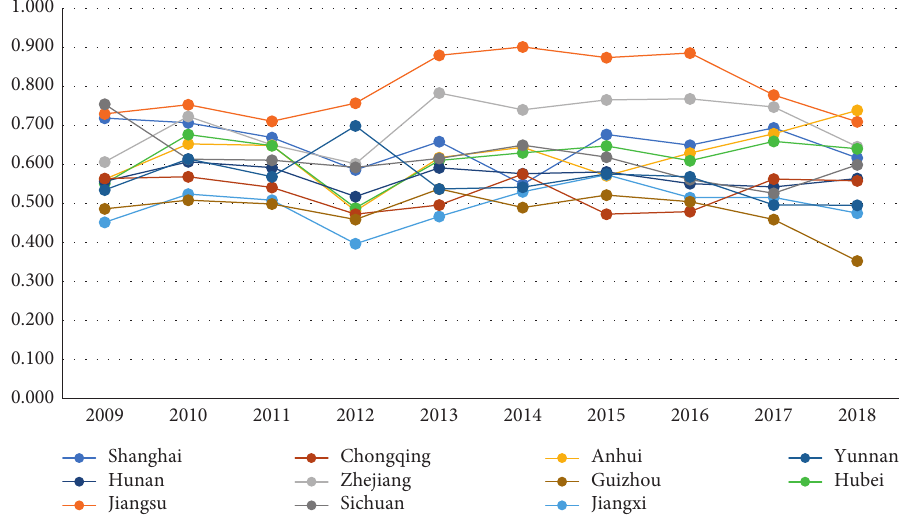
Figure 5: Temporal evolution of CCD.